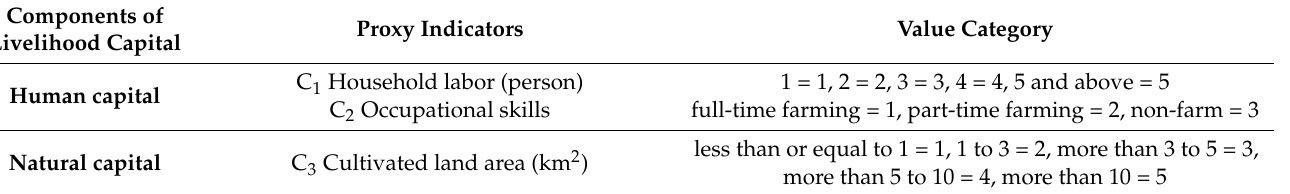
Table 1. Key variables of livelihood